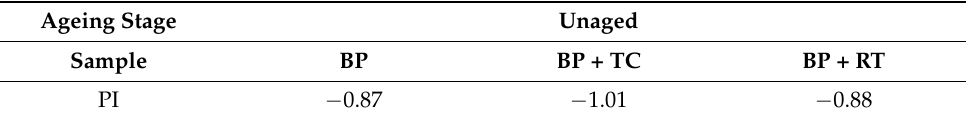
Table 3. Penetration index values.